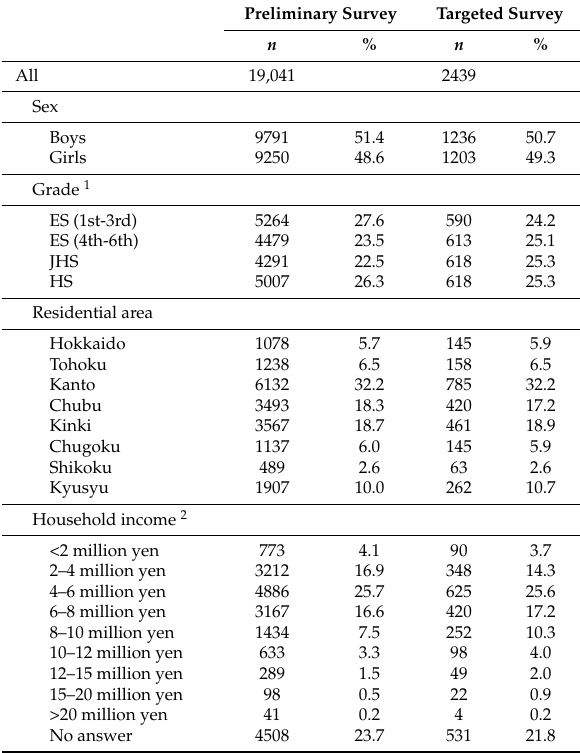
Table 1. Characteristics of the children of surveyed